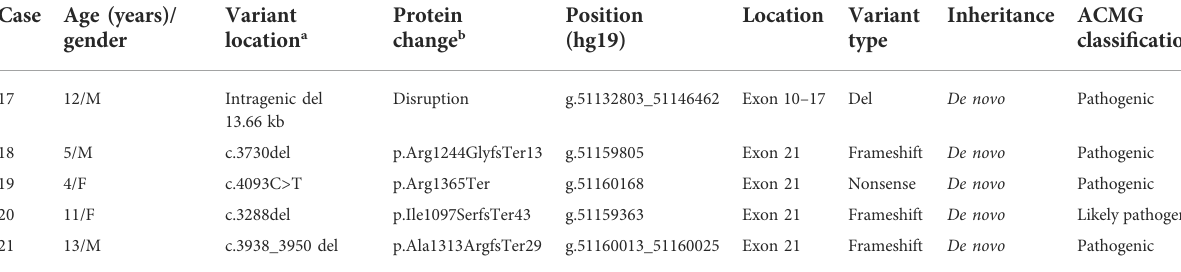
TABLE 2 Intragenic deletion and four pathogenic variants in the SHANK3 gene of fi ve